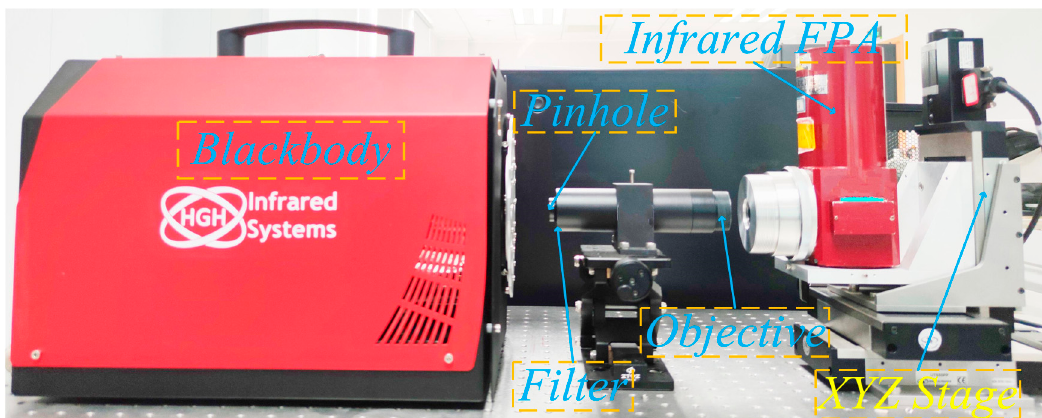
Table 1. In addition, the infrared FPA with a cut-off wavelength of 2.5 µ m is mounted on